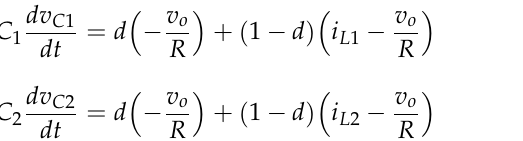
Figure 5. Important waveforms related to the capacitors from top to bottom, respectively: capacitor voltage, current, and switching voltage, current, and switching function.